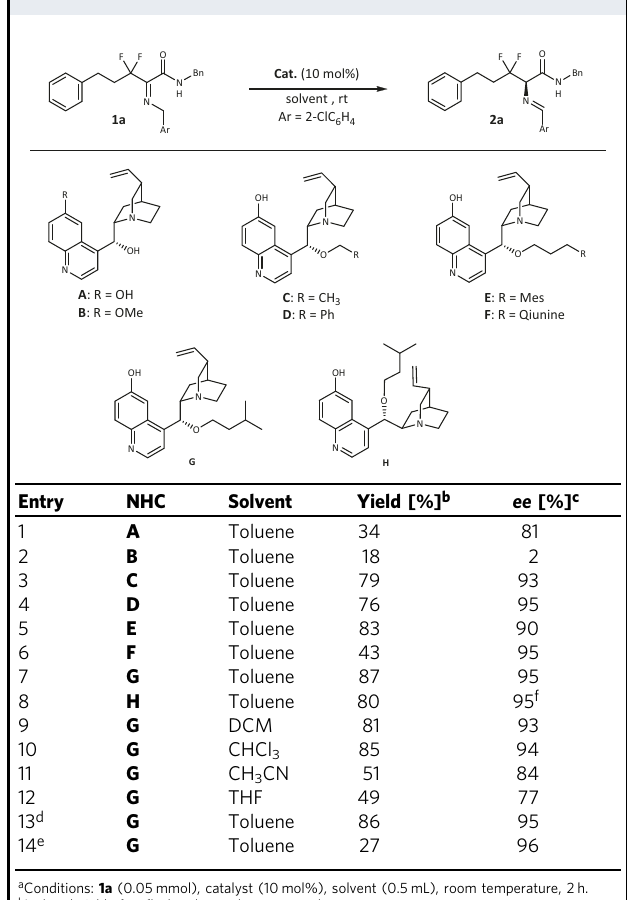
Fig. 2 Strategies for asymmetric synthesis of β , β -di fl uoro- α -amino acid derivatives. Strategies, a enzymatic hydrolysis; b asymmetric hydrogena- tion; c chiral auxiliaries. Valuable molecules: di fl uoro peptides, di fl uoro amino alcohols, and di fl uoro alkaloid. Table 1 Optimization of asymmetric isomerization of 1a a .